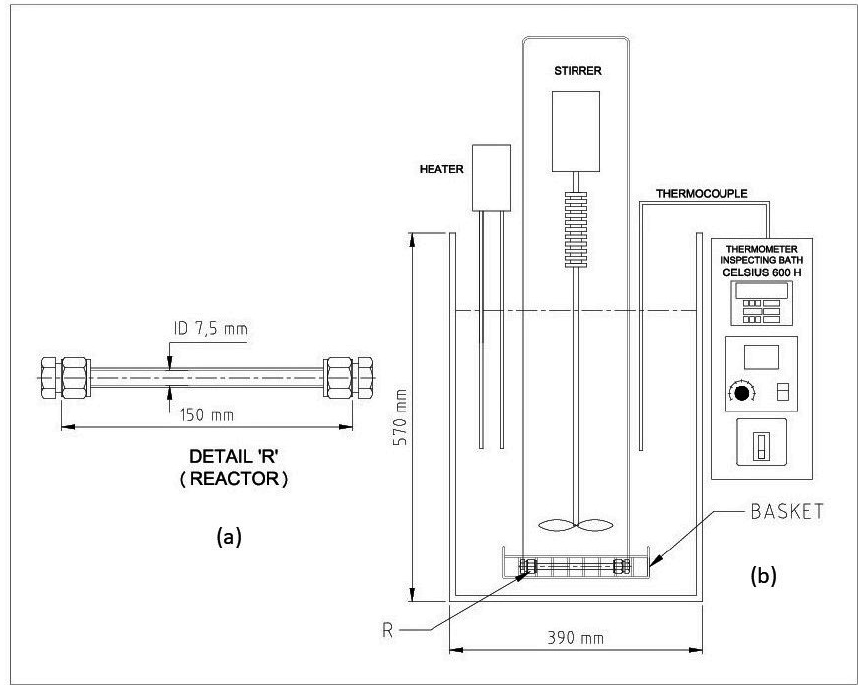
Fig. 1. Experimental equipment of pressurized hot water extraction: